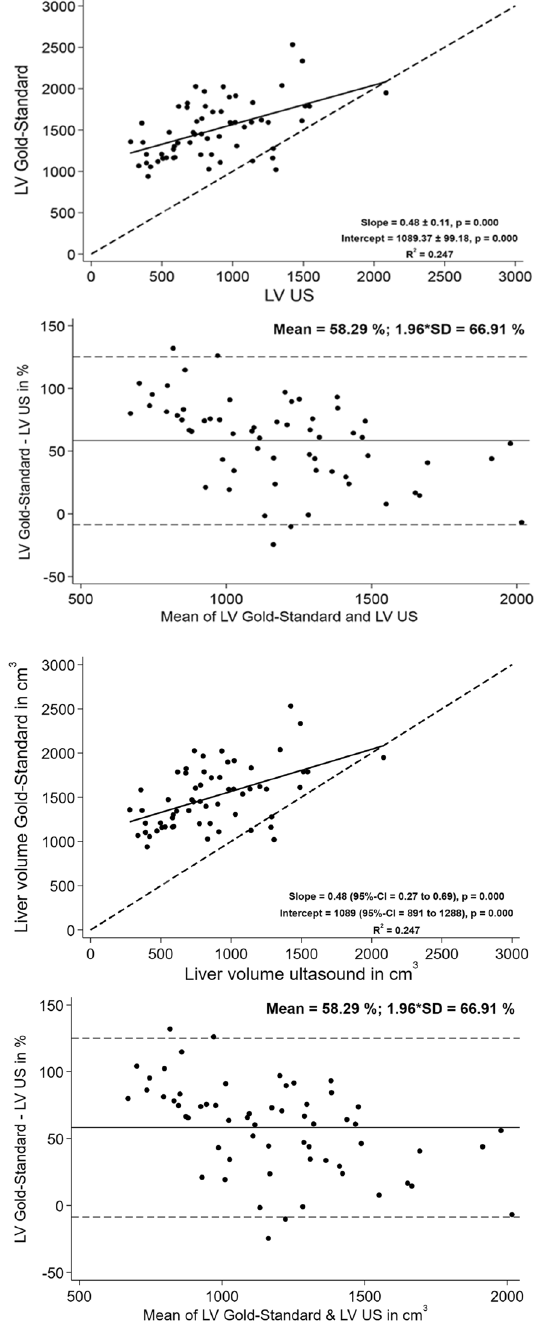
Figure 6. Linear correlation and Bland–Altman correlation between calculated VI from US and true liver